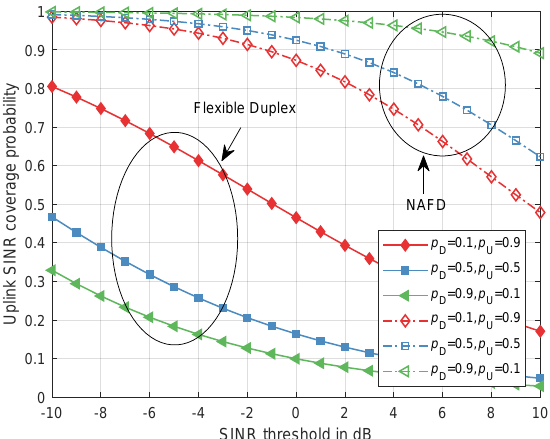
Figure 5. The comparison of uplink SINR coverage probability between the traditional flexible duplex system and the NAFD system.